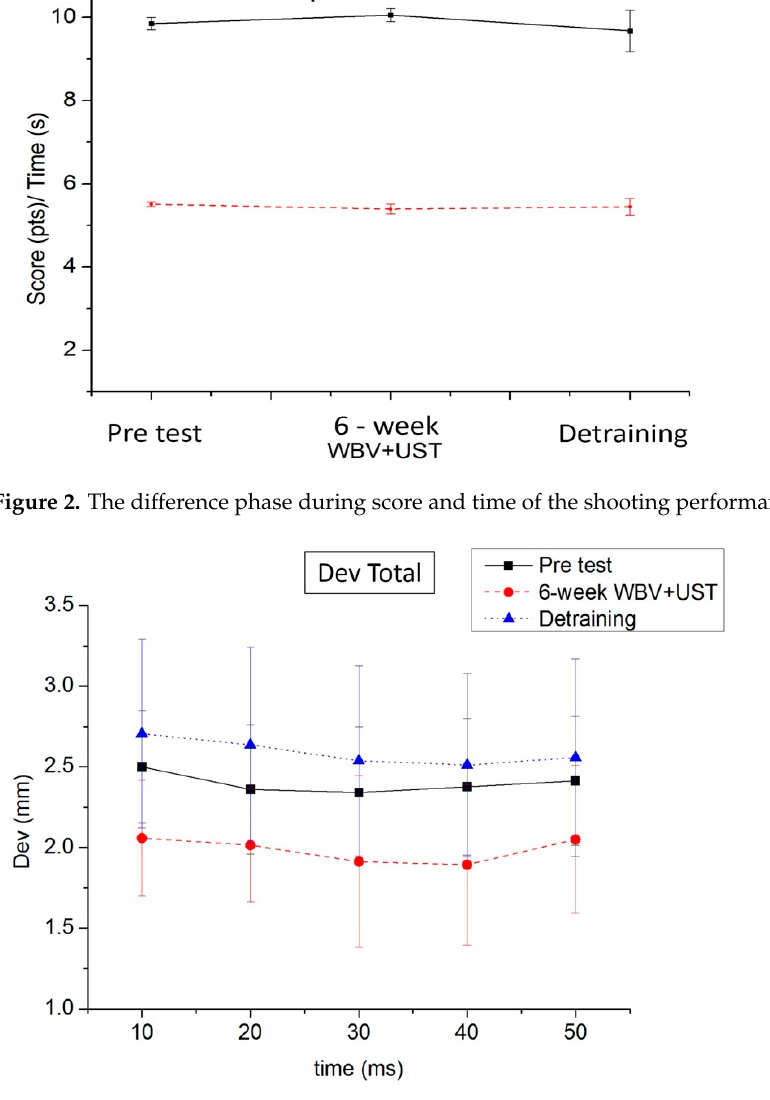
Figure 4. The difference phase during 10–50 ms-DevY of the shooting performance. For the shooting score, the one-way RM ANOVA showed a significant difference be- tween testing times (F = 23.730, p < 0.01, power = 0.985). The shooting scores during the 6 week WBV+UST ( p < 0.01, 6.25%) greatly improved, relative to those of the pretest. Post hoc testing indicated that the 6 week WBV+UST led to improvements after the pretest performances (Table 3). For the total time, the one-way RM ANOVA showed a significant difference between testing times (F = 5.909, p < 0.05, power = 0.553). The shooting score after the 6 week WBV+UST (2.00%) greatly improved, relative to the pretest performance (Table 3 and Figure 2). On the shooting performance test, we recorded the trajectory values of the rifle under the 10–50 ms-DevTotal and 10–50 ms-DevY categories. For the 10–50 ms-DevTotal values, the one-way RM ANOVA showed a significant difference between performances at dif- ferent times: 10 ms (F = 10.610, p = 0.01, power = 0.979), 20 ms (F = 6.292, p = 0.04, power = 0.579), 30 ms (F = 9.811, p = 0.02, power = 0.766), and 40 ms (F = 9.025, p = 0.02, power = 0.732). Furthermore, the 10 ms-DevTotal values after the 6 week WBV+UST ( p = 0.04,